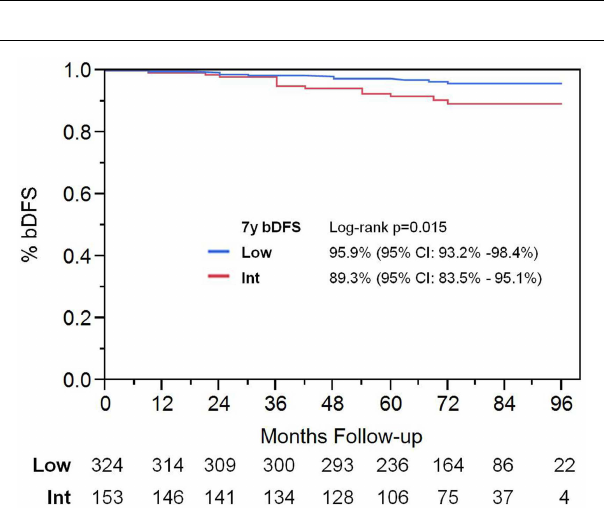
FIGURE 1 | Biochemimical disease-free survival in entire patient cohort .